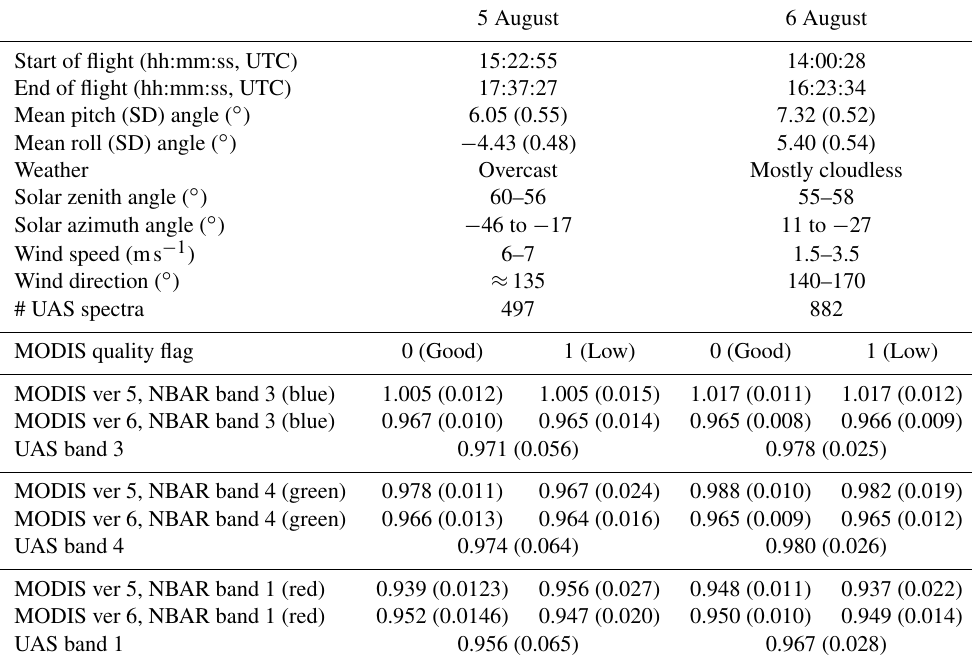
Table 2. Information for the two UAS MODIS route overpass flights. For the NBAR values the average value is given together with the standard deviation in